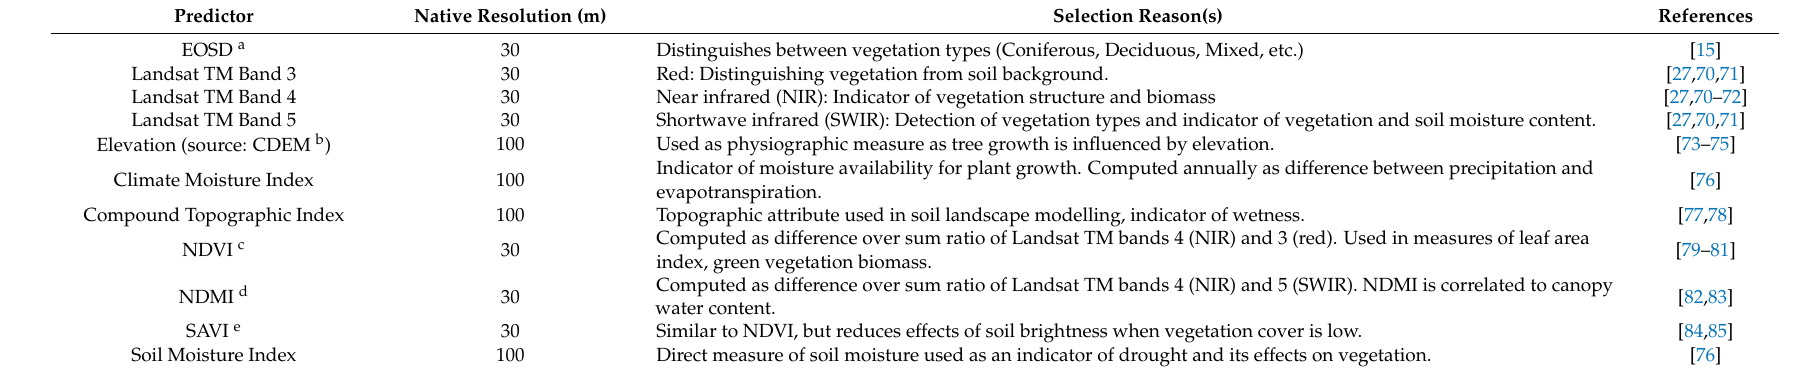
Table 2. Summary of all predictors available for forest attribute predictions via the k-nearest neighbour